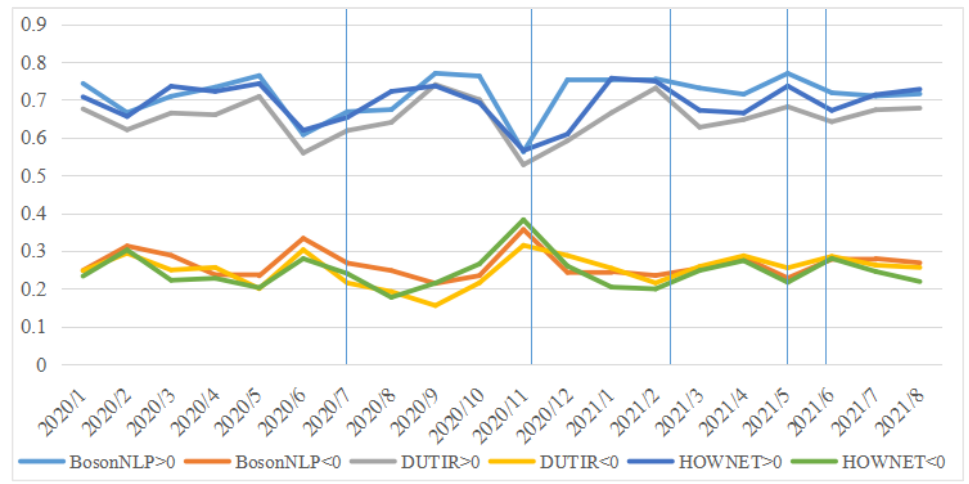
Figure 7. Changes in sentiment polarity of comments before and after policy implementation.